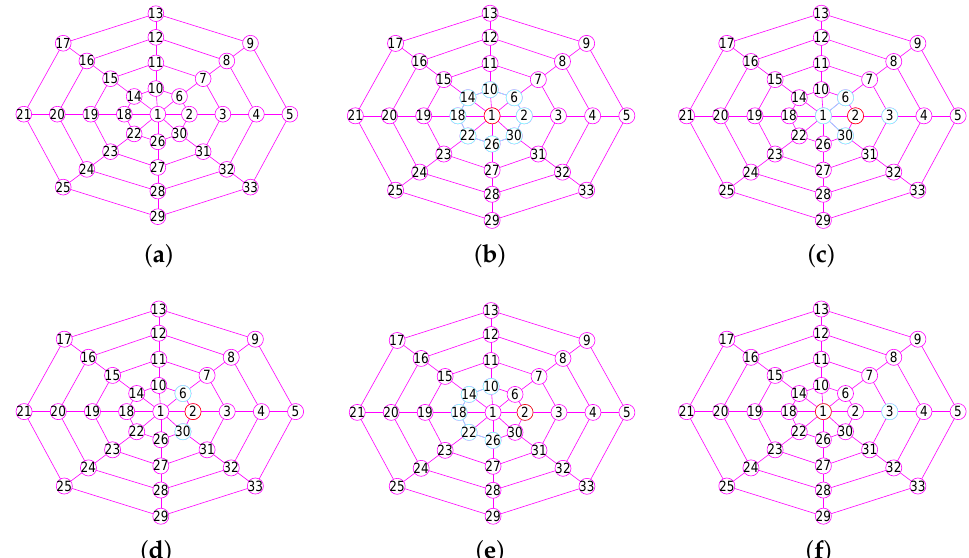
Figure 5. A wheel graph G , the 1-neighborhood subgraphs N ( 1 ) and N ( 2 ) and the three related vertices sets produced by the boolean operations of N ( 1 ) and N ( 2 ) . ( a ) A wheel graph G ; ( b ) The neighborhood subgraph N ( 1 ) ; ( c ) The neighborhood subgraph N ( 2 ) ; ( d ) V ( N ( 1 )) ∩ V ( N ( 2 )) = { 6,30 } ;